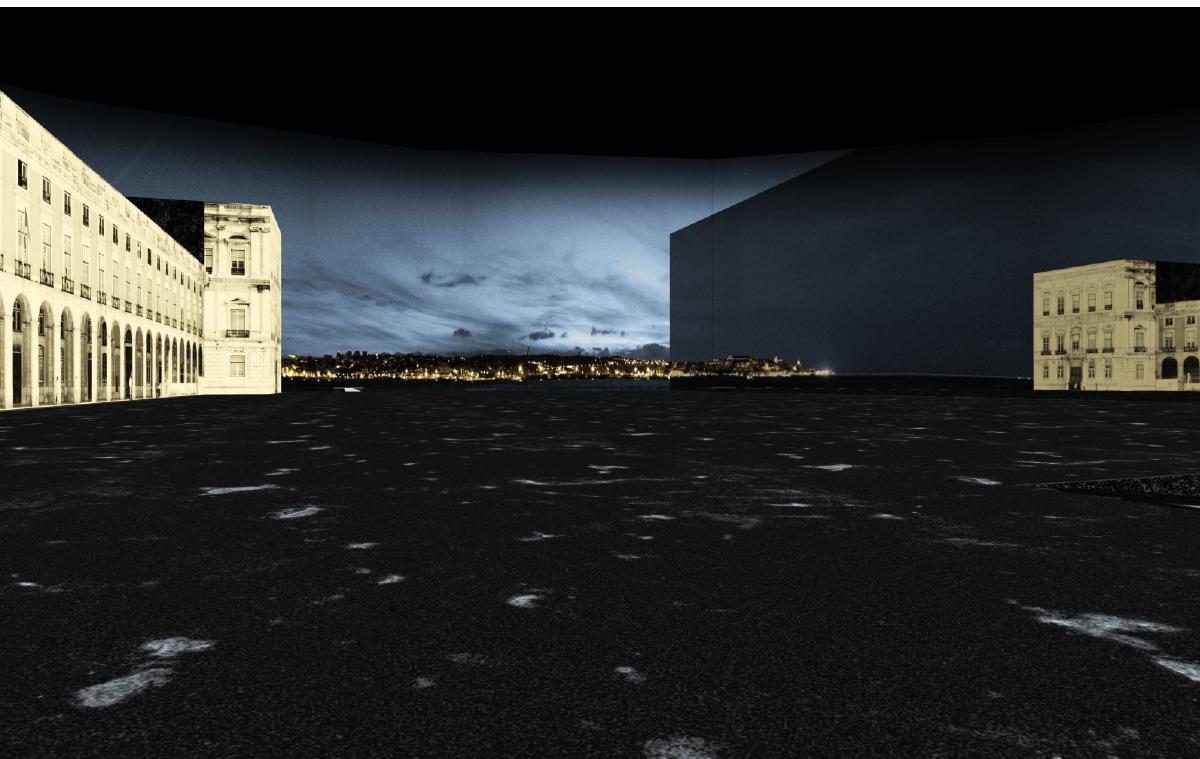
Fig. 7 Lisbon model: Praça do Comerçio to the Tejo river In modeling worlds MIC we used three ingredients: basic pur- poses, leading metaphors and infographic instruments. The most important intention is to preserve the ‘depht’ of the urban im- age, considering that the depth of the urban 'face' or 'facade' is one of the essential characteristics of urban experience. And precisely the inability to perceive this complexity and richness is the main reason for the poor experience produced by many real and virtual